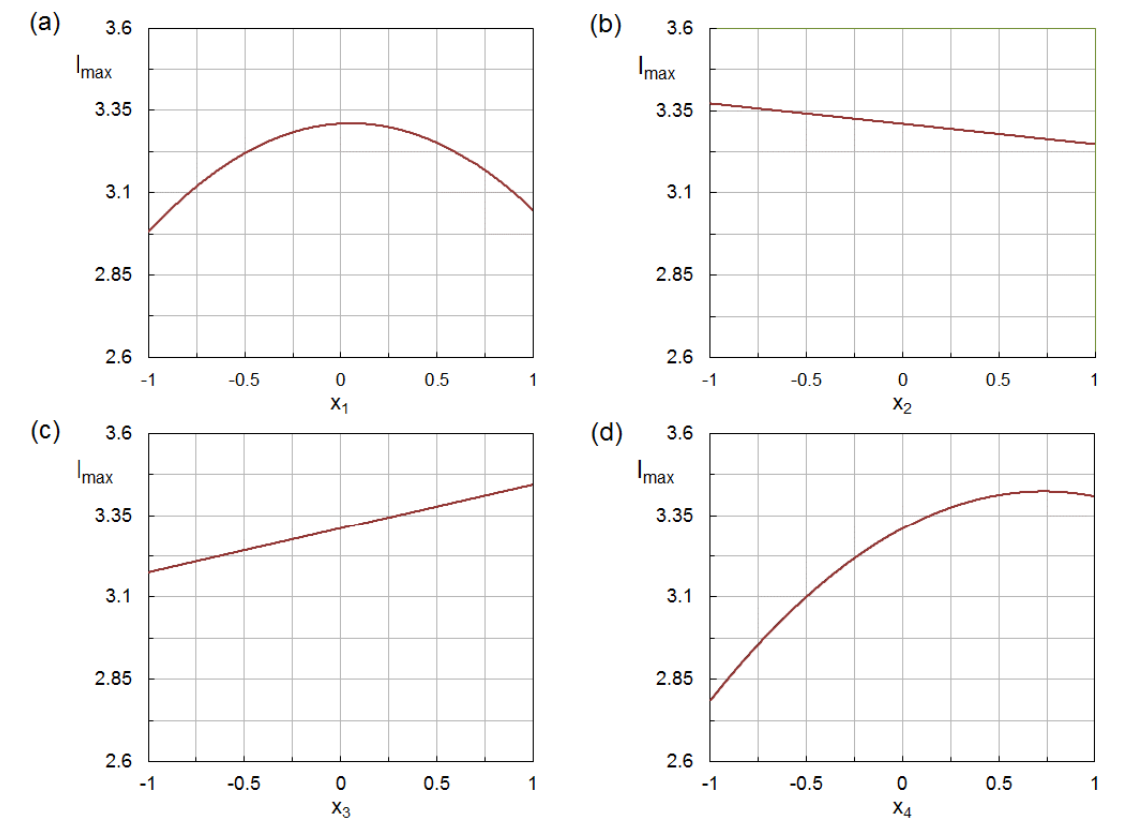
Figure 5. Perturbation plots for the four factors: ( a ) solvent composition; ( b ) silver-to-phenolic ratio; ( c ) temperature; and ( d ) pH. Each diagram was plotted by keeping the levels of the other three factors at their central value.